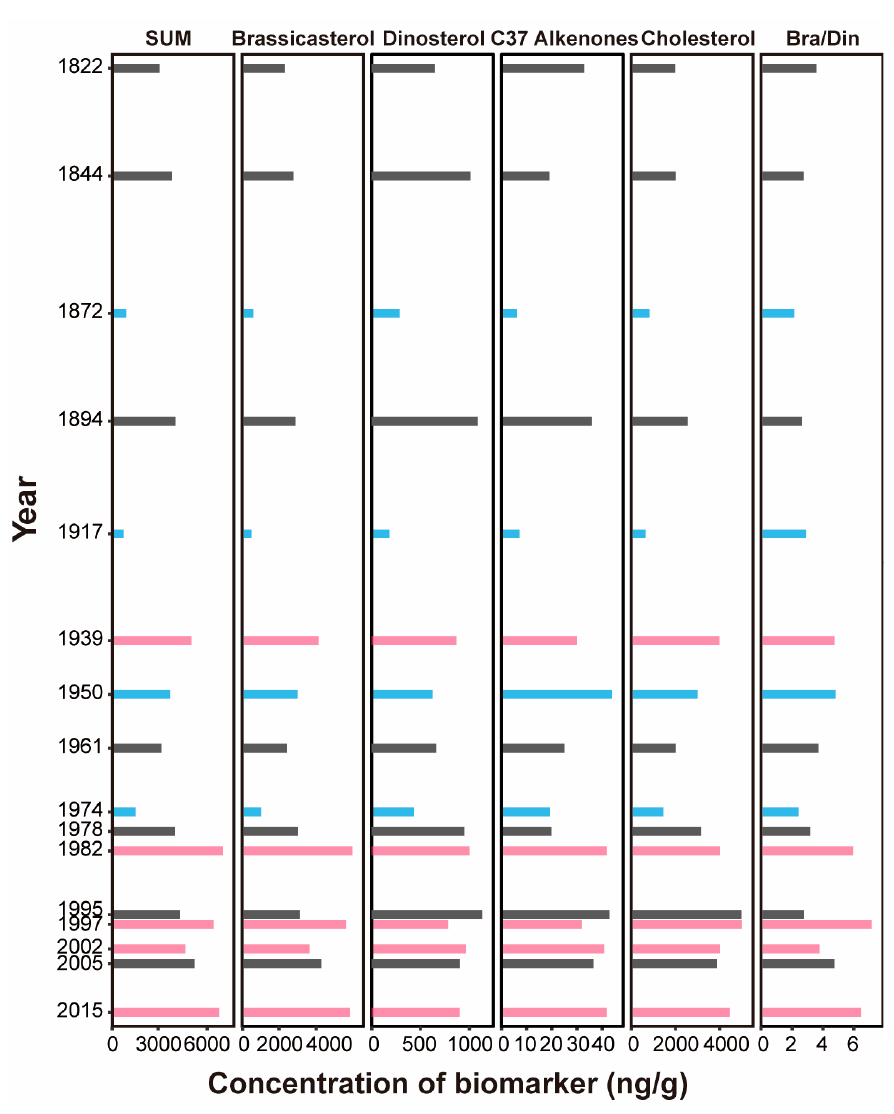
Figure 4. Changes in plankton biomarker concentrations and ratios of brassicasterol to dinosterol from 1822 to 2015 (Red, El Niño years; blue, La Niña years; gray, normal